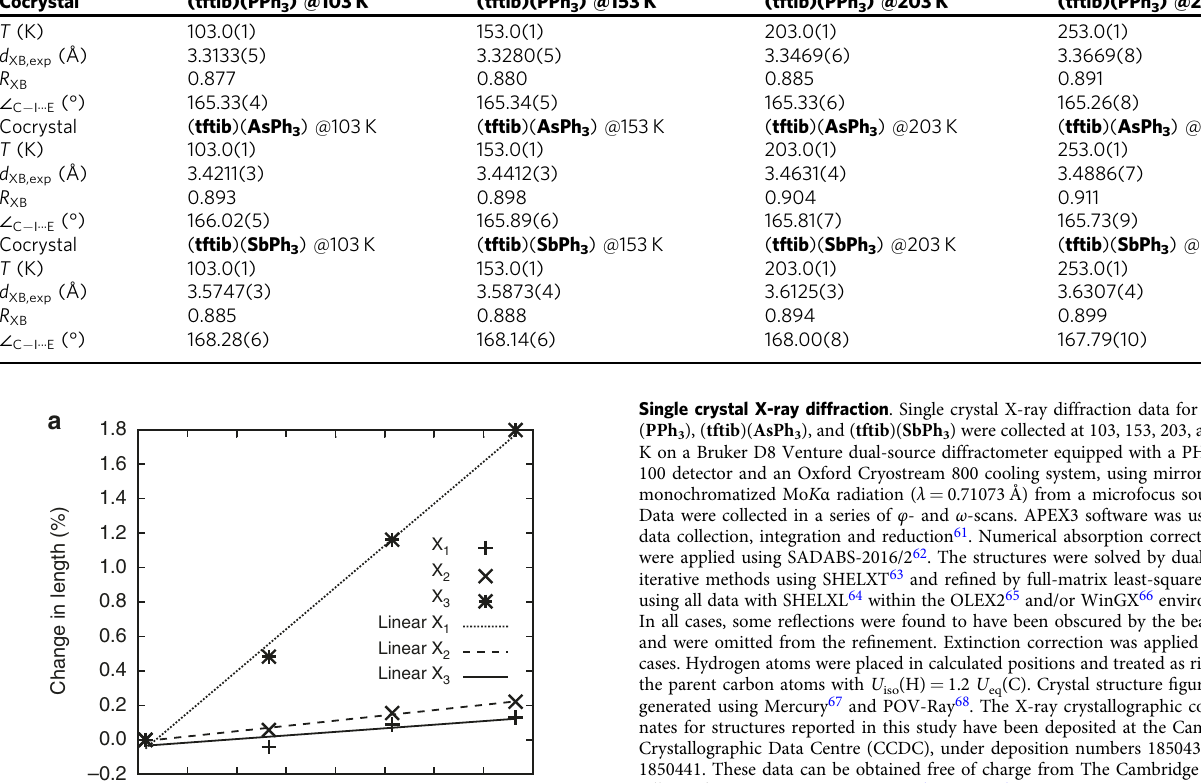
Table 4 Geometrical parameters of C − I···E (E = P, As, Sb) halogen bonds at different temperatures Cocrystal